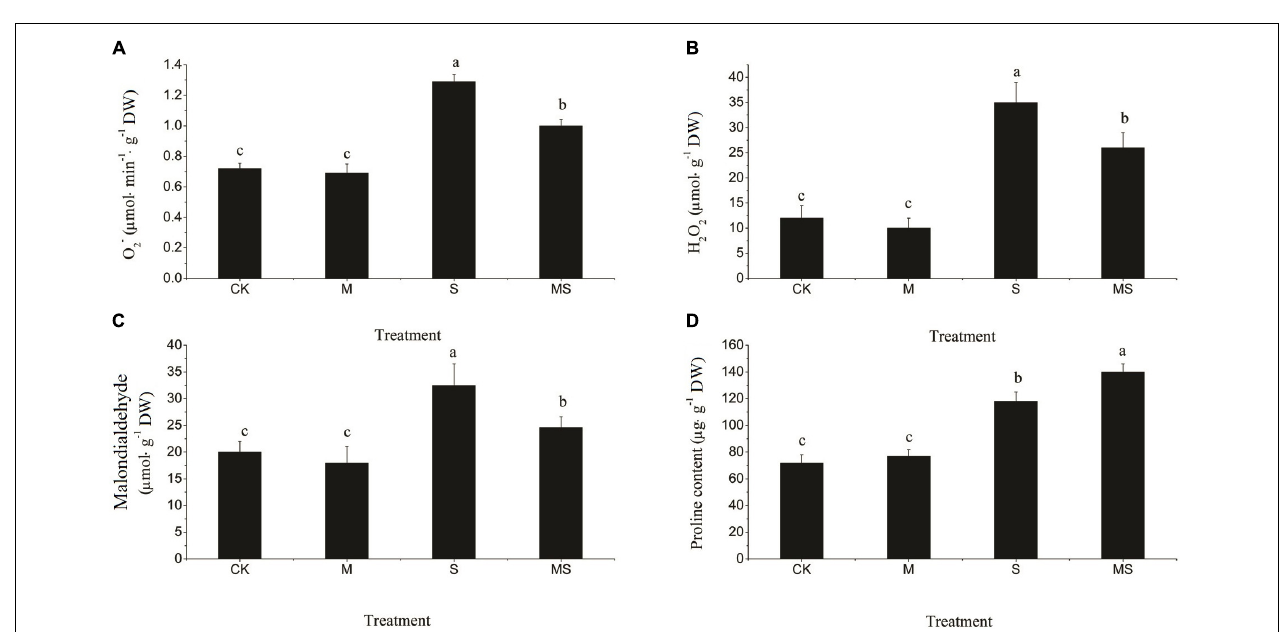
FIGURE 1 | Leaf water uptake of watermelon inoculated or non-inoculated seedlings with AMF Funneliformis mosseae and subjected or not to salinity-alkalinity stress from 4 to 28 days. (A) Water relative content; (B) water use efficiency. AMF, arbuscular mycorrhizal fungi; CK, without AM inoculation + without salinity-alkalinity; M, with AM inoculation + without salinity-alkalinity; S, without AM inoculation + with salinity-alkalinity; MS, with AM inoculation + with salinity-alkalinity. Values are means ± standard errors ( n = 10).